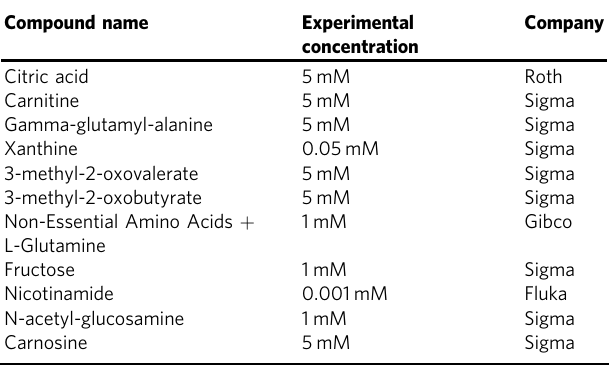
Table 1 Metabolites tested to for their support of L. rhamnosus growth in KBM.